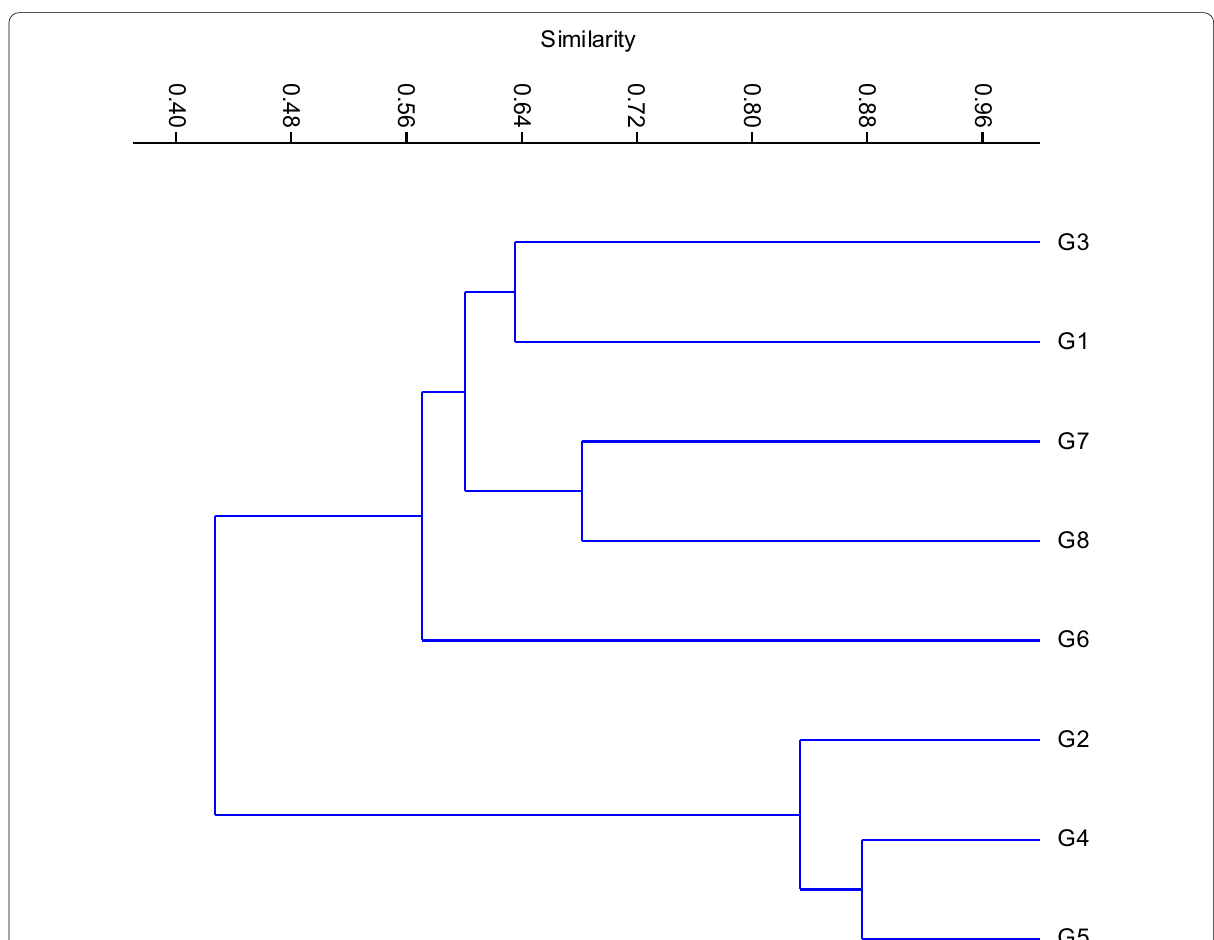
Fig. 4 Dendrogram representing the genetic relationship between the eight sugar beet genotypes using UPGMA cluster analysis of Nei‑Li’s similarity coefficient generated from the 12 ISSR